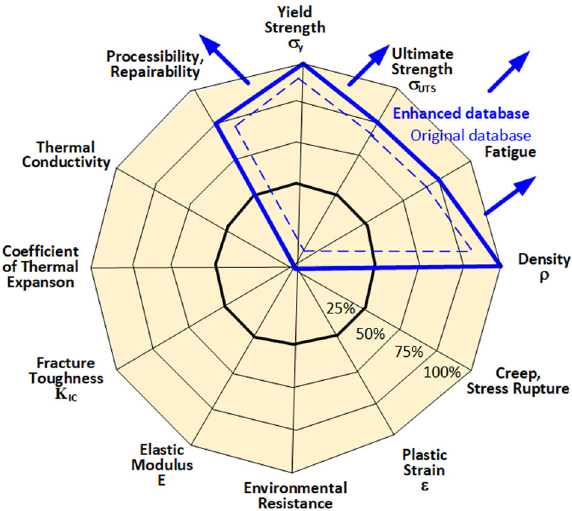
Fig. 8 Characterization of the HEA data contained in the database used for the present